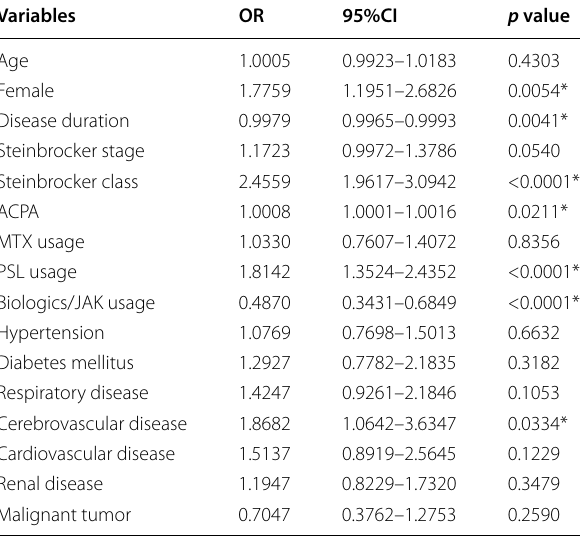
Table 3 Multivariate logistic regression analysis for the moderate or high disease activity in rheumatoid arthritis